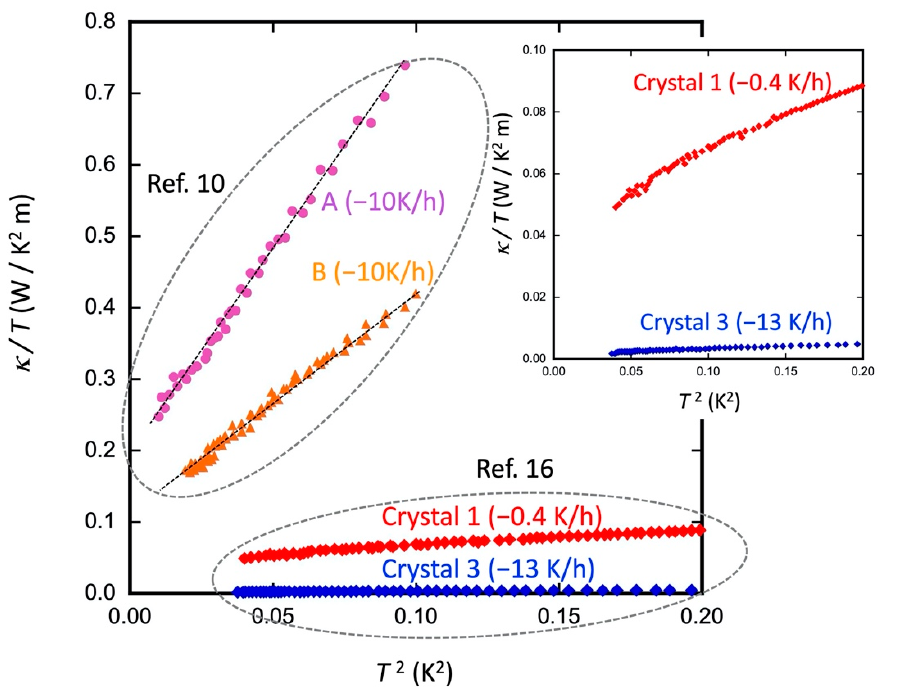
Figure 5. Two different sets of the thermal conductivity ( κ ) data for β′ -EtMe 3 Sb[Pd(dmit) 2 ] 2 from [10,16]. The cooling rate in each measurement is indicated in a parenthesis. The inset is an enlarged view of the data from [16]. The behavior of κ reported in [11,12] is similar to that of crystal 3 ( − 13 K/h) in [16].